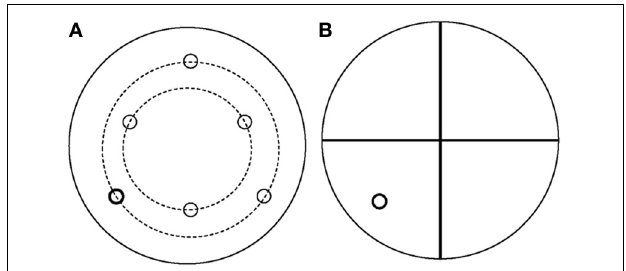
FIGURE 1 | Schematic of the water maze apparatus used for both spatial reference and spatial working memory tasks. (A) Schematic of the platform locations. (B) Example of quadrant orientations used for analysis used for the platform indicated in bold. Quadrant locations were always oriented so that the platform was central within a